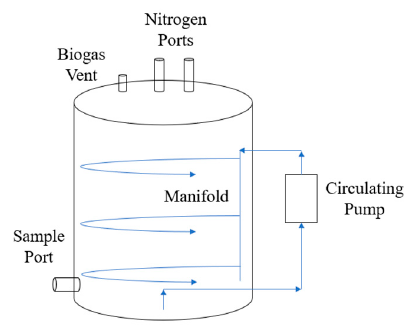
Figure 1. Reactor schematic. Effluent was circulated using a small inline pump and removed from the center of the reactor vessel and recirculated using a vertical manifold.